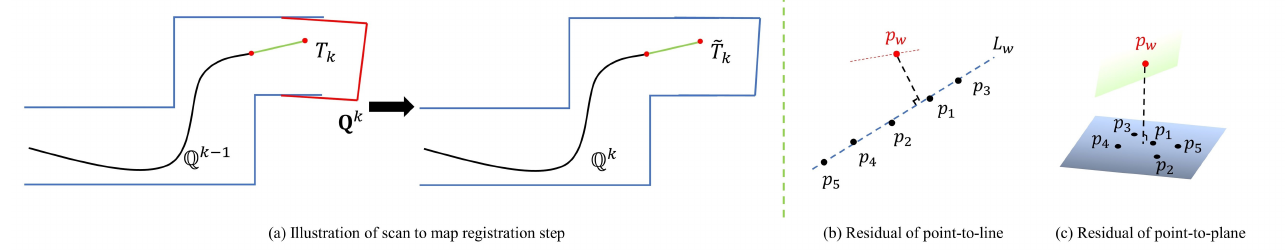
Figure 7. ( a ) Illustration of scan to map matching and map registration. ( b ) Residual of point to line. ( c ) Residual of point to